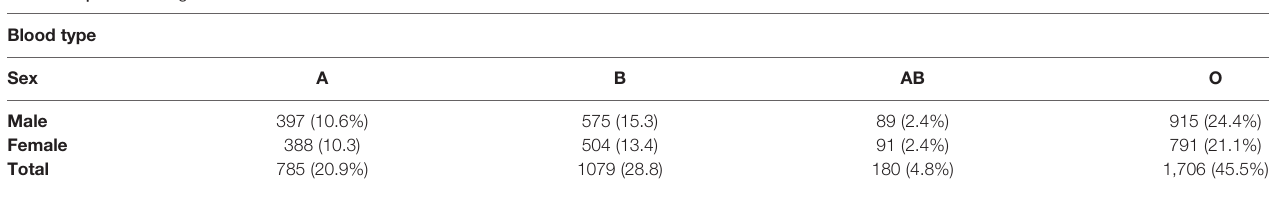
TABLE 1 | Haematological characteristics of the